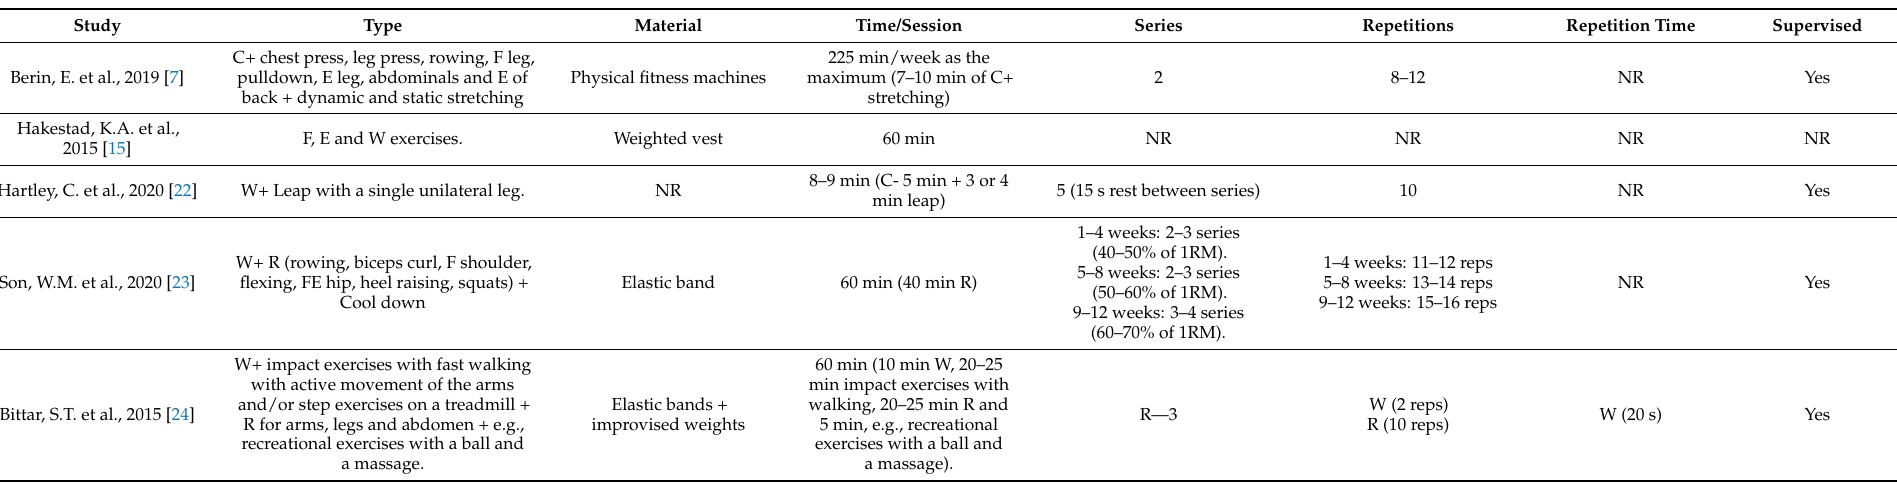
Table 2. Characteristics of the Strength Exercise Interventions Included in this